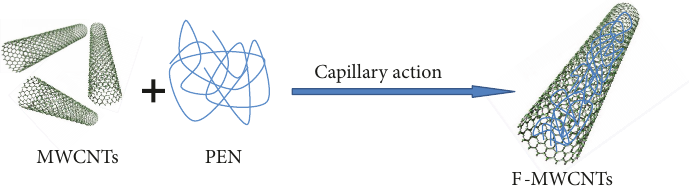
Figure 9: Schematic illustration of fabrication of